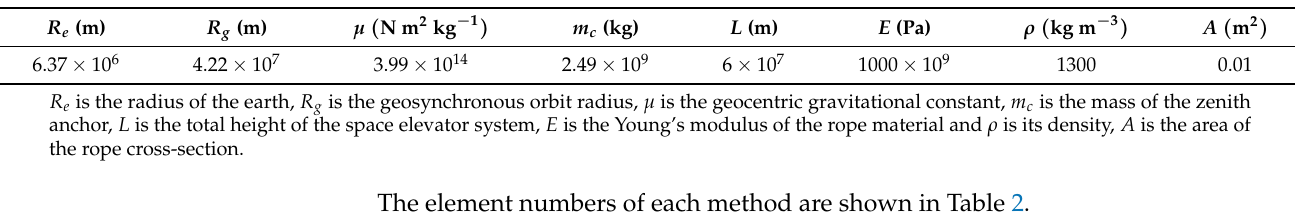
Table 1. System parameters.